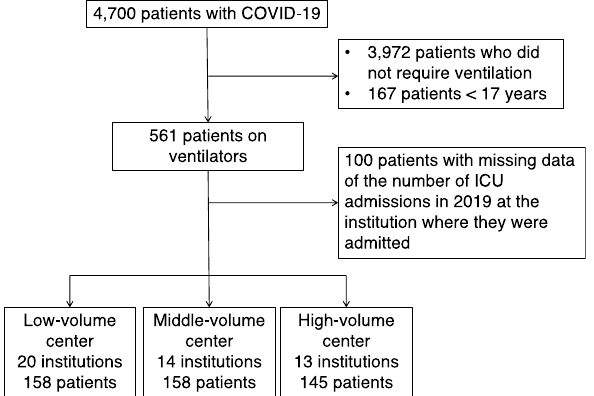
Figure 1. Flowchart of the study.